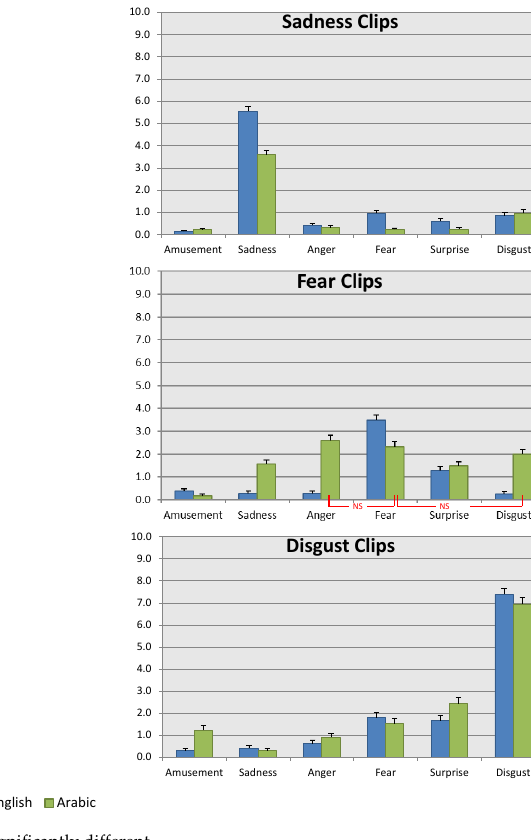
Figure 7. Emotion elicitation average self-rate and its standard error for both English and Arabic